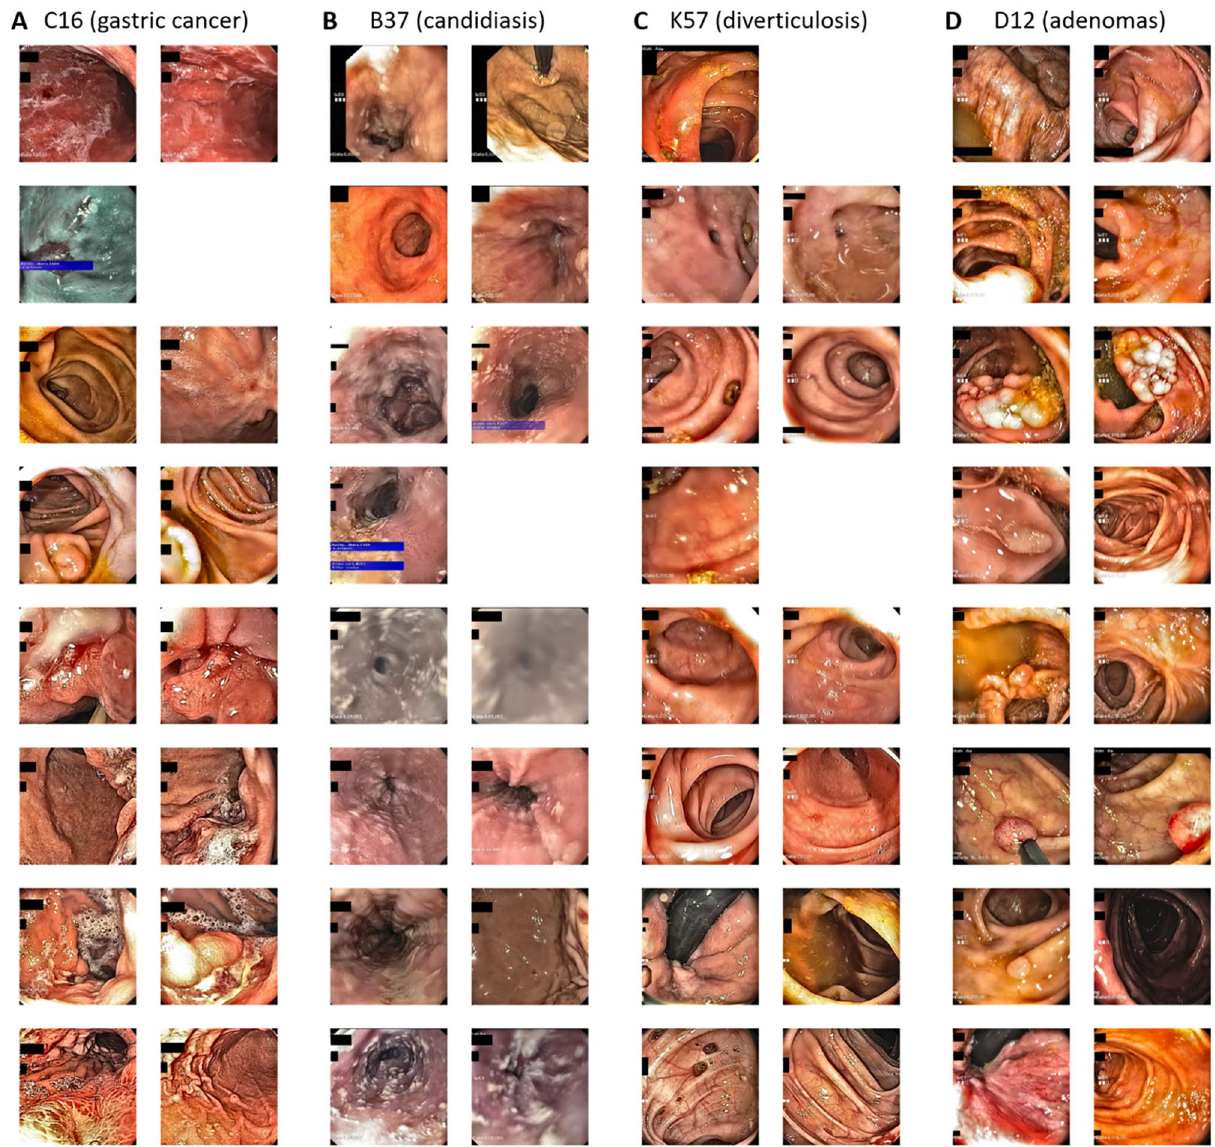
gastroscopy dataset: ( A ) C16, ( B ) B37, and the colonoscopy data set: ( C ) K57 and ( D )